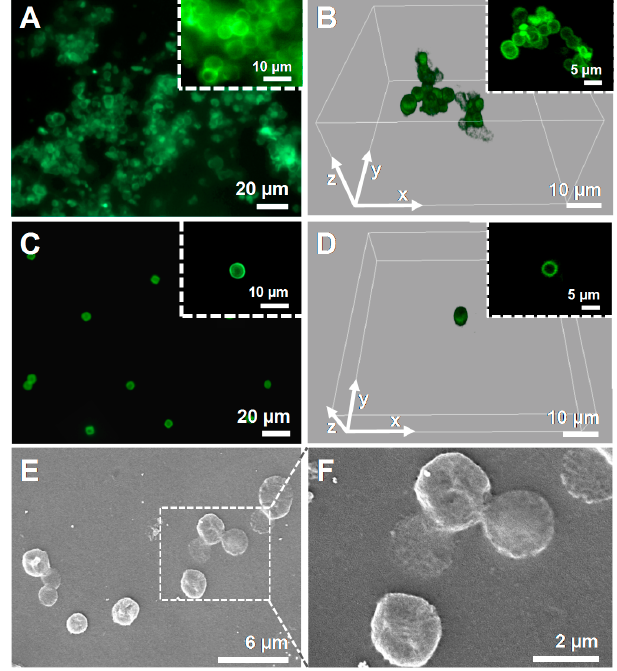
Figure 3. ( A , C ) FL microscopy and ( B , D ) CLSM micrographs of (CHT/ALG) 2 -based hollow multilayered microcapsules before ( A , B ) and after ( C , D ) the dialysis purification step. Green channel: FITC-labeled CHT. The insets in B , D correspond to the middle plane of the microcapsules. ( E , F ) SEM micrographs of the (CHT/ALG) 2 -based hollow multilayered microcapsules after dialysis, showing folds and creases in their structure due to the drying